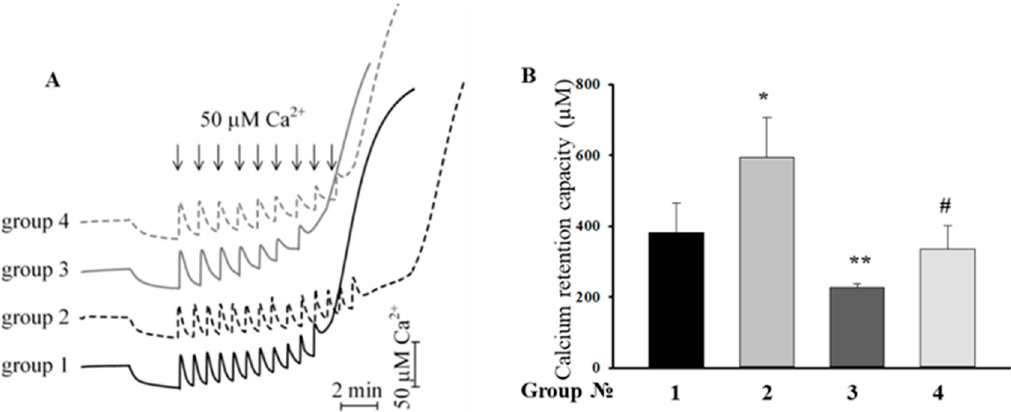
Figure 4. Comparison of the calcium retention capacity of mitochondria isolated from different groups of rats. Group 1: Control animals, Group 2: animals treated with MEL (~7 mg/kg of body weight per day), Group 3: animals treated with ISO (85 mg/kg of body weight twice), Group 4: animals treated with MEL + ISO. ( A ) Records of Ca 2+ fluxes in RHM. Arrows show the times at which CaCl 2 (50 nmol of Ca 2+ per mg of protein) was applied; ( B ) Quantitative analysis of Ca 2+ retention capacity. The values shown are the means ± SD from three independent experiments. * p ≤ 0.05, ** p ≤ 0.01 vs. the Ca 2+ retention capacity of mitochondria from control rats (Group 1), # p ≤ 0.05 compared with the Ca 2+ retention capacity of mitochondria from animals treated with ISO (Group 3).